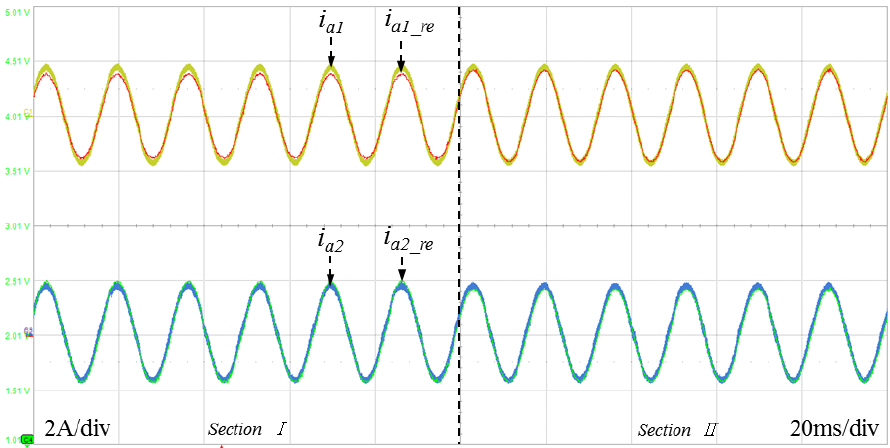
Figure 11. The actual current and reconstructed currents of the three phase current before and after the proposed offset compensation algorithm is applied in the inverter 1.